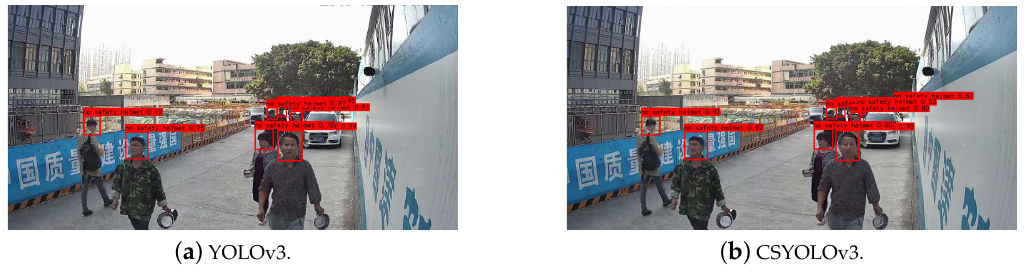
Figure 8. Results of occlusion SHW detection.